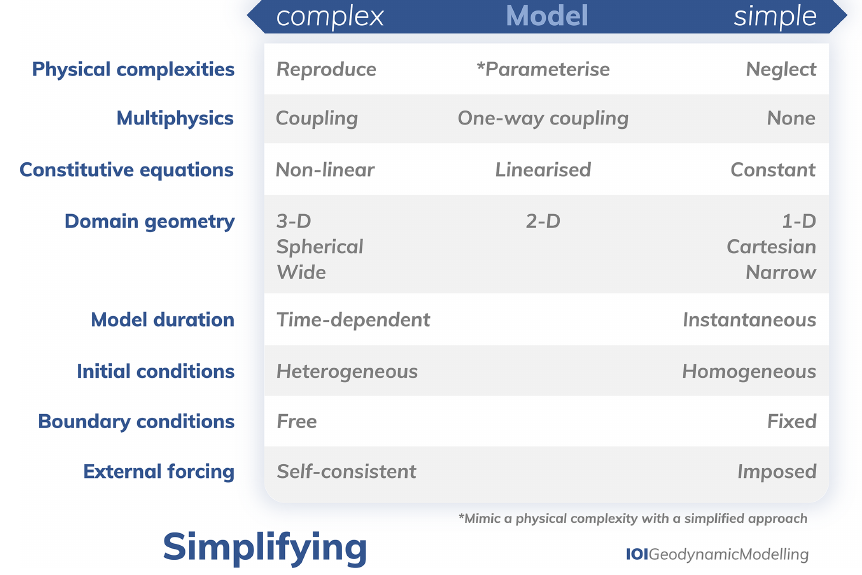
Figure 8. Potential options for geodynamic model simplification. Note that we mean “multiphysics” beyond the already coupled system described in Sect. 2 (see Sect. 3.8).